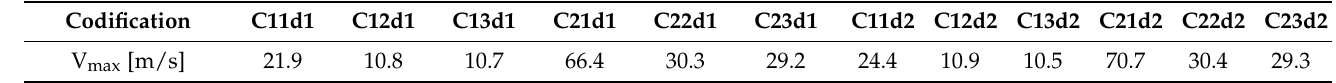
Table A1. Cases studied and their corresponding maximum concentration within the elbow.